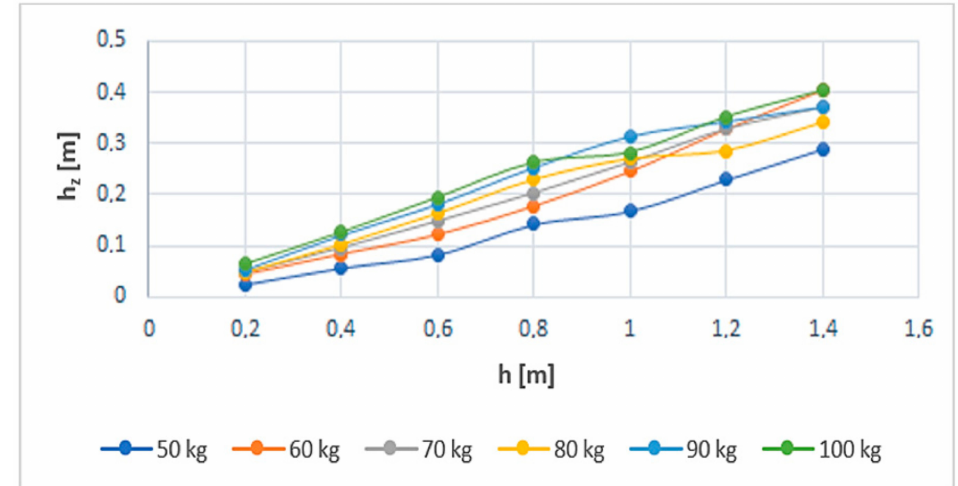
Figure 9. The correlation between the bounce height h z and the impact height h for the pyramidal